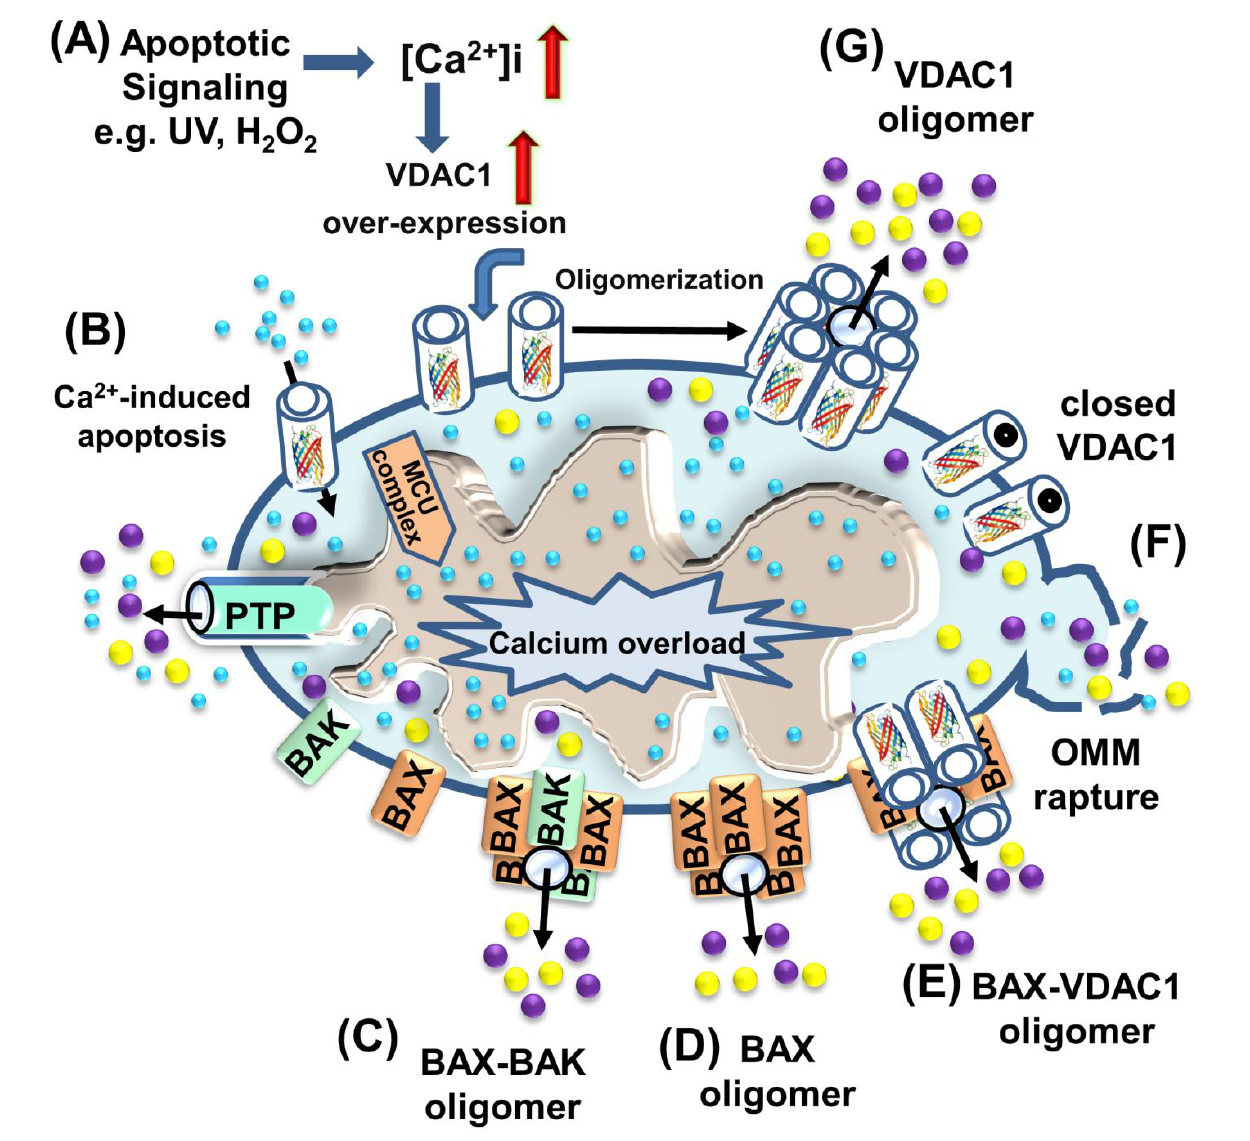
FIGURE 5: VDAC1 function in cell death, with apoptosis inducers enhancing VDAC1 expression levels and oligomerization. A schematic repre- sentation of VDAC1 function in cell death - Different models for the release of apoptogenic proteins, such as Cyto c (purple) and AIF (yellow), are shown. (A) Proposed model suggesting that apoptotic stimuli or conditions cause enhanced VDAC1 expression via increases in [Ca 2+ ]i levels or transcription factors, leading to activation of the VDAC1 promoter. The increase in VDAC1 expression shifts the equilibrium towards the VDAC1 oligomeric state, forming a hydrophilic protein-conducting channel capable of mediating the release of apoptogenic proteins (e.g., Cyto c and AIF) from the mitochondrial IMS to the cytosol. (B) Mitochondrial Ca 2+ overload induces apoptosis. Ca 2+ transport across the OMM, as mediated by VDAC1, and then across the IMM, as mediated by the MCU, leads to Ca 2+ overload in the matrix. This, in turn, causes dissipation of the membrane potential, mitochondrial swelling, PTP opening, Cyto c /AIF release and the triggering of apoptotic cell death. (C) Bax/Bak oli- gomerization and activation, forming a route for Cyto c /AIF release. (D) Bax activation leads to its association with the OMM, followed by its oligomerization as a large oligomer/complex, forming a Cyto c /AIF-conducting channel. (E) The interaction of the pro-apoptotic protein Bax with VDAC1 forms hetro-oligomers that mediate Cyto c/AIF release. (F) Prolonged VDAC1 closure leads to mitochondrial matrix swelling and OMM rupture, resulting in the appearance of a non-specific release pathway for apoptogenic